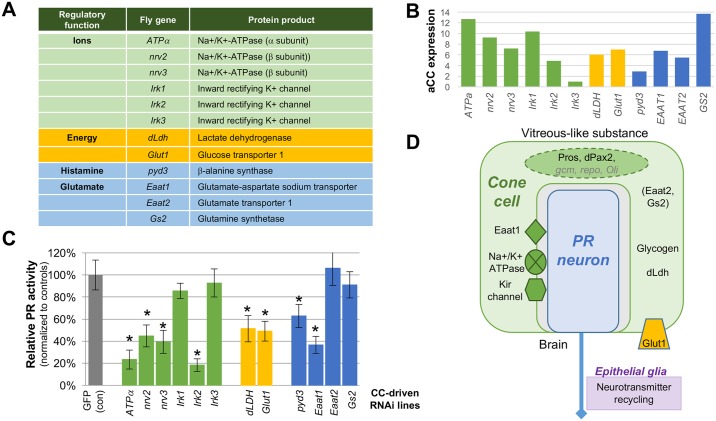
Functional dependence of cone cell-expressed glial effectors on photoreceptor physiology.(A) Table of 12 conserved glial genes tested for CC-dependent PR activity support functions. (B) TMM-normalized RNA expression levels of candidate genes from (C) in adult cone cells. (C) Relative PR activity (normalized to day-matched controls, +/- SEM) for CC knockdowns with prosPSG-GAL4 (*p<0.001). Eight show significant reductions in PR activity, including those that are typically associated ion maintenance (AtpαRNAI-1, nrv2RNAI-1, nrv3RNAi-1 and Irk2RNAi-1), metabolism (dLDHRNAi-1 and Glut1RNAi-1) and histamine and glutamate recycling (pyd3RNAi-1 and EAAT1RNAi-1). Four (Irk1RNAi-1, Irk3RNAi-1, EAAT2RNAi-1 and GS2RNAi-1) were statistically similar to controls. (D) Schematic of the glial factors expressed in and required by CCs for supporting retinal integrity and function. The transient expression of gcm, repo, and Oli are reflected by lighter font. Parentheses indicate glial factors with abundant mRNA expression in CCs, but whose function was not defined here. The role of epithelial glia in neurotransmitter recycling, a synaptic event that occurs in the brain and which we found to be genetically separable from CCs, is also noted.